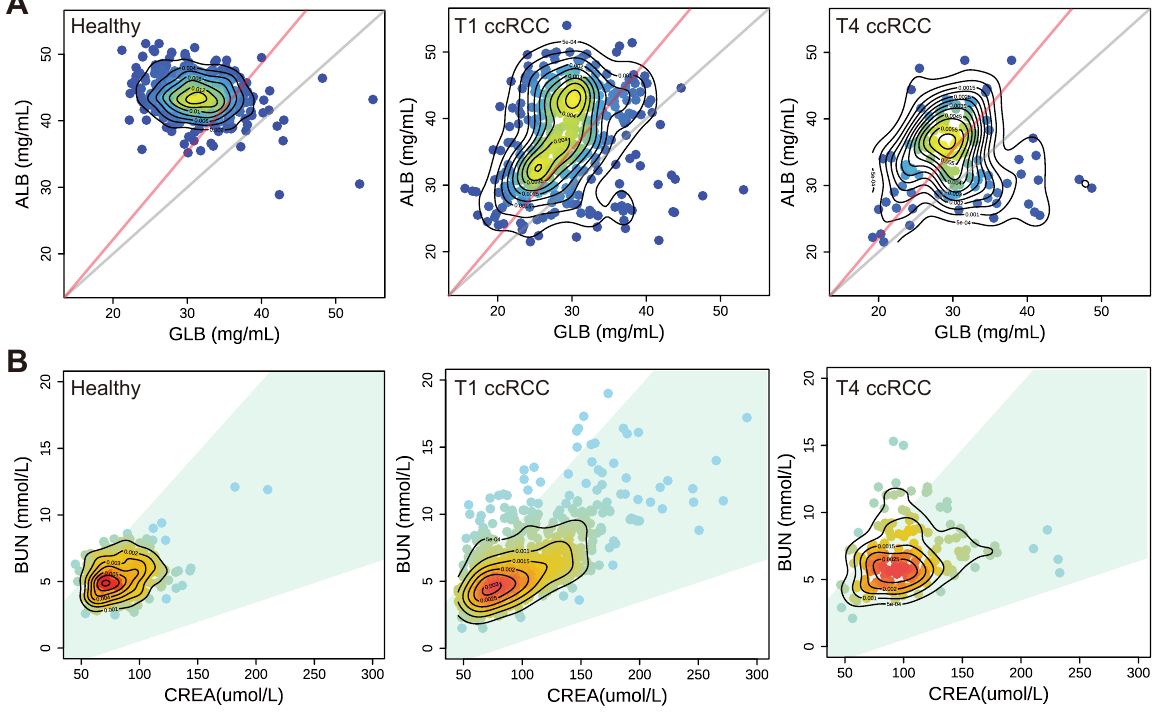
Figure 4. The distribution of AGR and BCR in healthy and cancer populations. ( A ) The distribution of AGR in the healthy population and ccRCC patients (red line is AGR = 1.2; grey line is AGR = 1). ( B ) The CREA : BUN ratio distribution in the healthy population and ccRCC patients (the green area is the BCR normal range